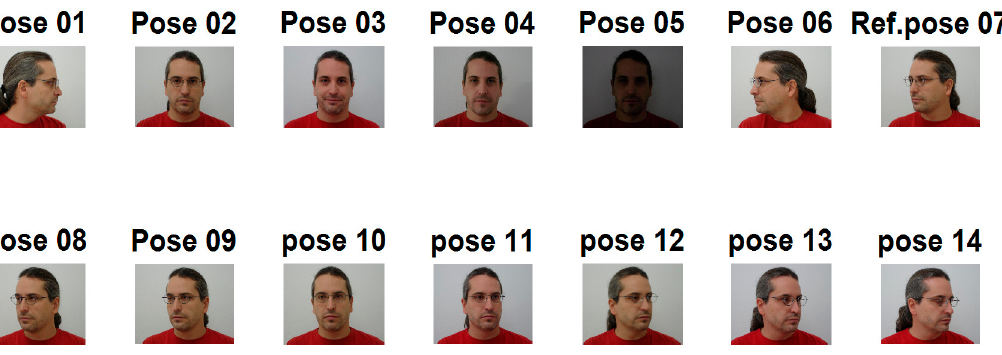
Figure 5. Poses for person No. 5 in FEI database.